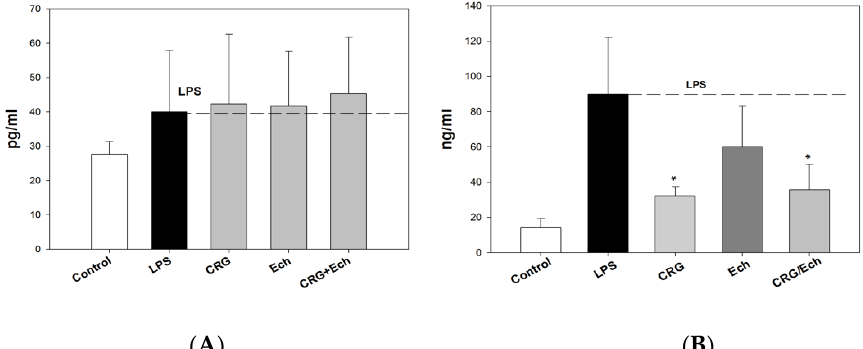
Figure 5. The levels of anti-inflammatory Il-10 ( A ) and pro-inflammatory TNF- α ( B ) cytokines in mice sera under oral administration of — CRG, Ech, CRG/Ech (24 h before injection of LPS). The dose of orally sample was 100 mg/kg. Values are means 6 SD (n 5 10). The data are shown as the means ± SE; * Significantly different from control (saline), p < 0.05.